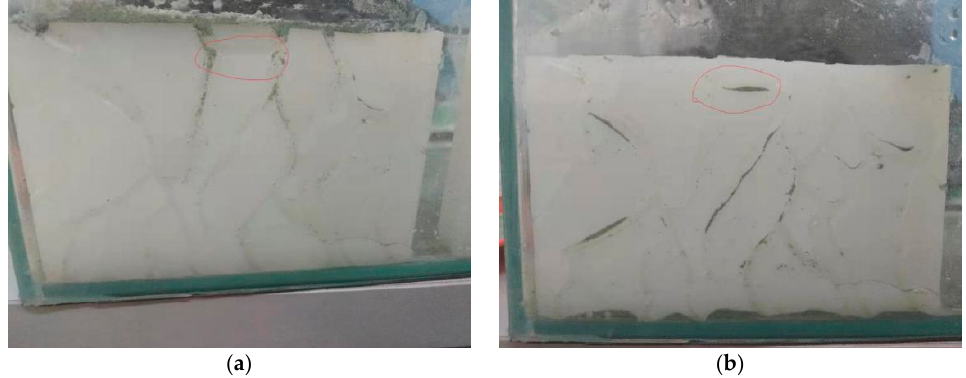
Figure 9. ( a ) Blockage with dry blockage. ( b ) Blockage with impact of water